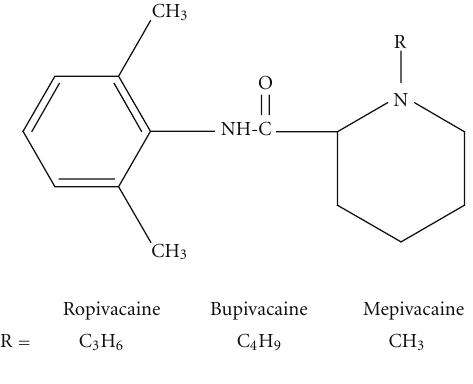
Figure 2: Amide local